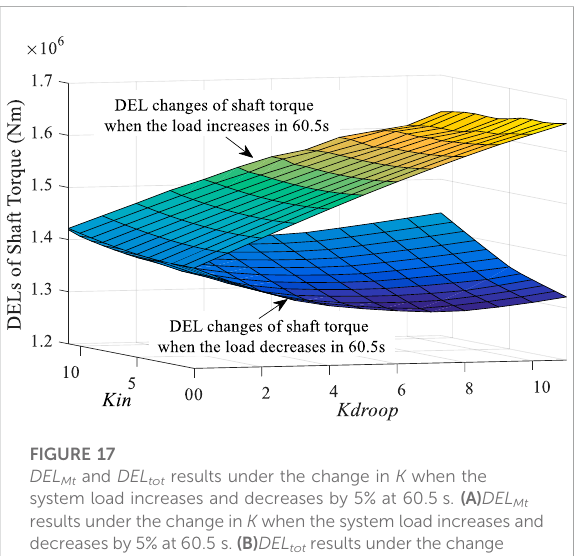
FIGURE 17 DEL Mt and DEL tot results under the change in K when the system load increases and decreases by 5% at 60.5 s. (A) DEL Mt results under the change in K when the system load increases and decreases by 5% at 60.5 s. (B) DEL tot results under the change in K whenthesystemloadincreasesanddecreasesby5%at60.5 s.